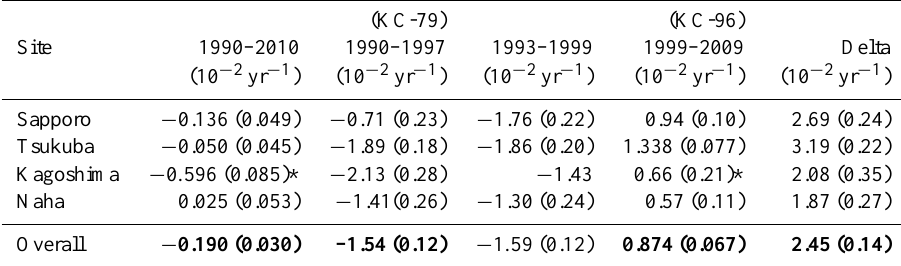
Table 4b. As in Table 4a, but using the balloon burst climatology for the above burst altitude